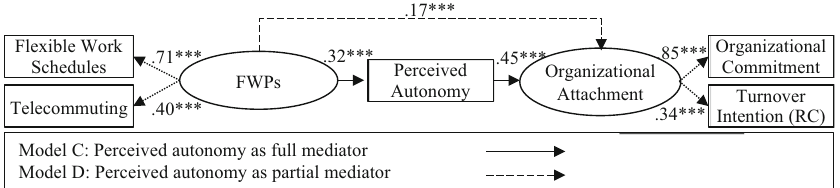
Fig. 4 Model linking FWPs to internal outcomes . FWPs flexible work practices; sabbaticals missed as FWP indicator due to a lack of studies, RC reversely coded; values represent standardized coefficients for model D; *** p \